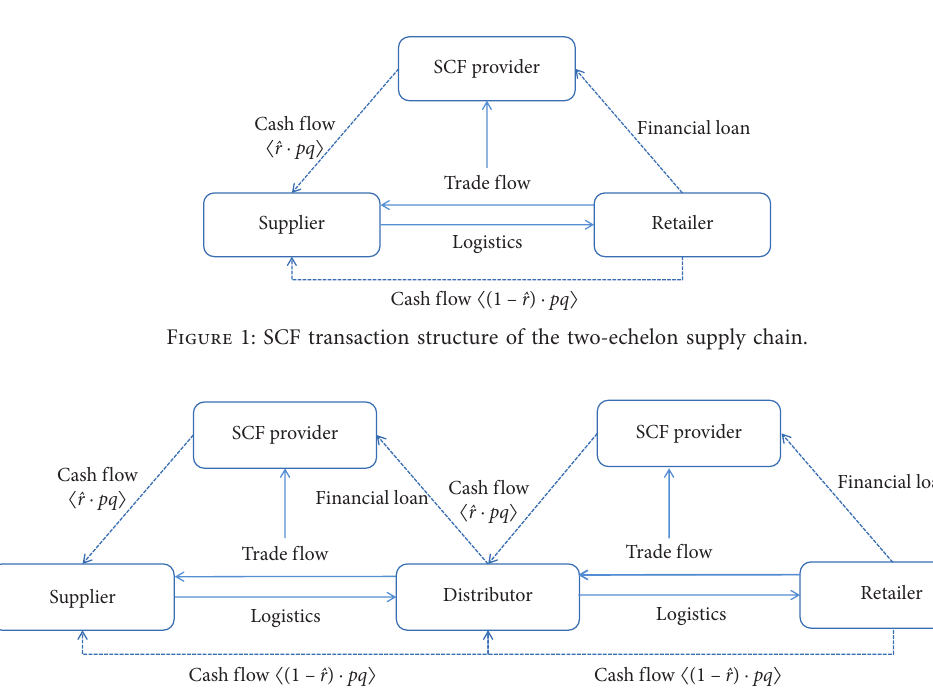
Figure 2: SCF transaction structure of the three-echelon supply